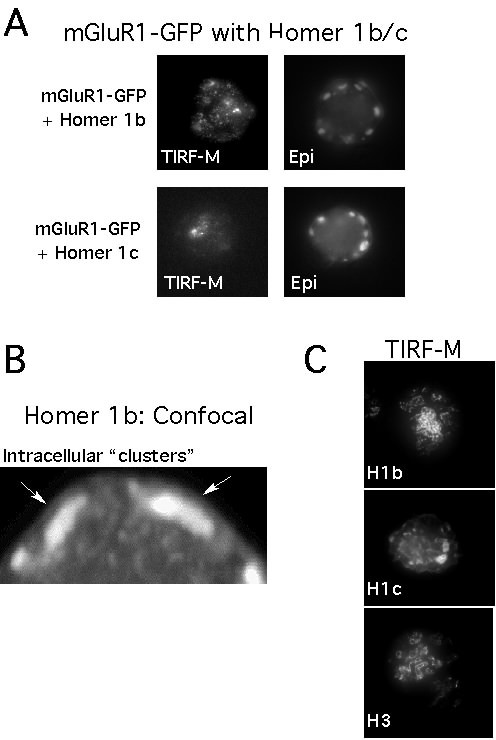
Differential cluster formation in SCG neurons expressing mGluR1-GFP with Homer 1b. A, Examples of Homer 1b and 1c co-expressing cells with surface clustering (TIRF; left), and apparent intracellular aggregations of mGluR1-GFP (Epifluorescence; right). B, Expanded views of a confocal image showing intracellular aggregations of receptor clusters taken from a Homer 1b co-expressing cell. C, Anomalous mGluR1-GFP distribution induced by Homer proteins indicated in a small number of TIRF-M images.